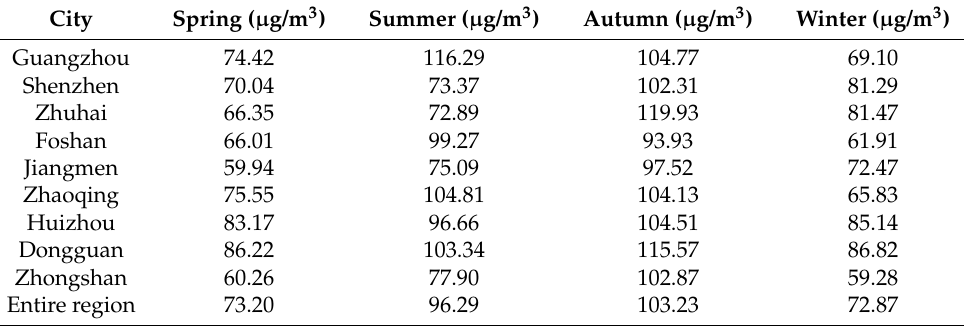
Figure 4. Spatial distribution of ozone concentration during spring, summer, autumn, and winter in the Pearl River Delta Metropolitan Region. Table 3. Seasonal average ozone levels in various cities in urban areas of the Pearl River